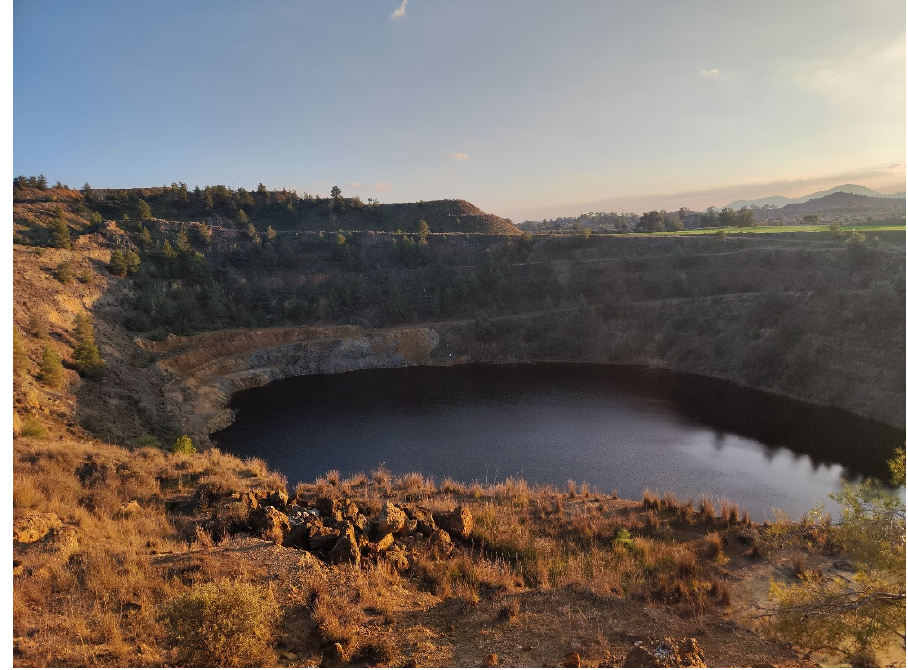
Figure 1. South view of the abandoned open pit North Mathiatis mine (Personal photo of Papaconstantinou).